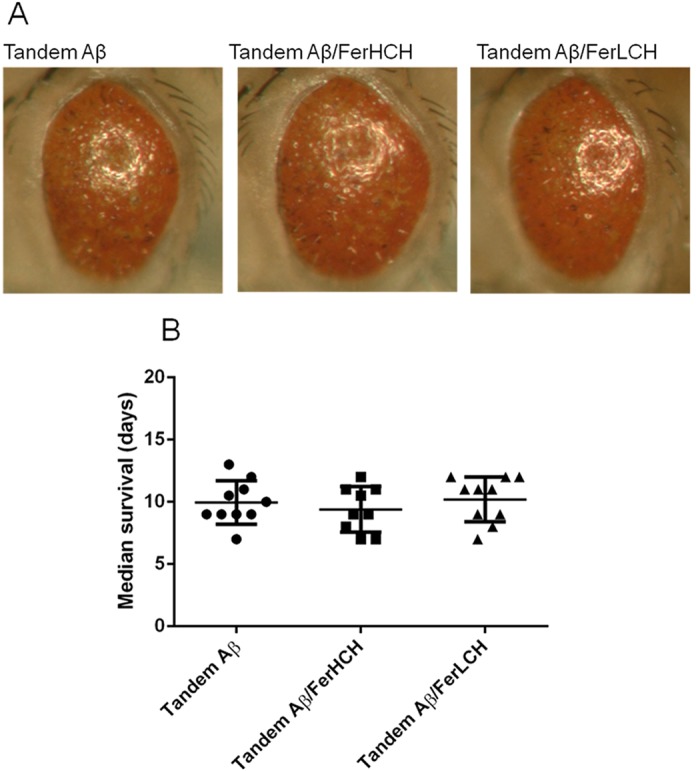
Co-expression of ferritin subunits does not rescue tandem Aβ42 toxicity. (A) Neither FerLCH nor FerHCH co-expression suppressed the rough-eye phenotype induced by tandem Aβ42 driven in the eye by GMR-gal4. Crosses were performed at 25°C and maintained at 29°C until eclosion. (B) In agreement with the rough-eye assessment, pan-neuronal elavc155-gal4-driven expression of FerLCH or FerHCH also did not prolong the lifespan of flies co-expressing tandem Aβ42. Crosses were performed at 18°C and maintained at 25°C after hatching.